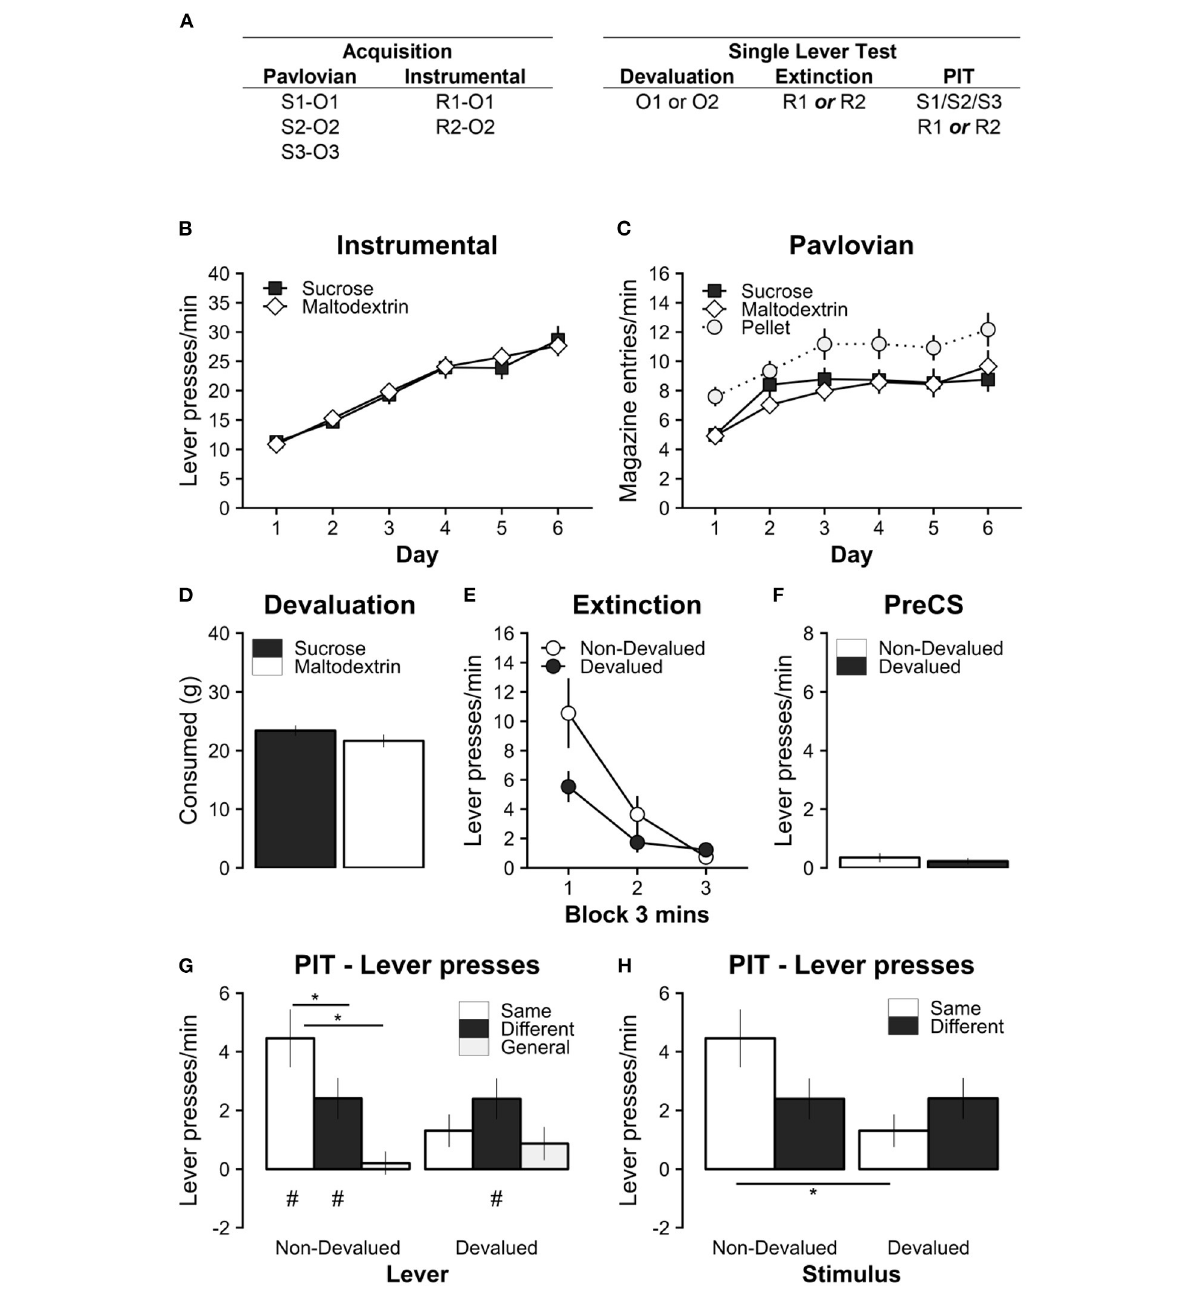
FIGURE2 Experiment 2 tested the effect of outcome devaluation by sensory-specific satiety on specific PIT in a single-lever test. (A) Experimental design; S1/S2/S3: clicker, tone, and noise stimuli (counterbalanced); R1/R2: left and right lever press actions (counterbalanced); O1/O2: sucrose and maltodextrin liquid reinforcer outcomes (counterbalanced); O3: pellet reinforcer outcome. (B) All rats learned to perform the left and right lever responses for the sucrose and maltodextrin liquid reinforcers. (C) All rats learned that the Pavlovian stimuli uniquely predicted the sucrose, maltodextrin, and pellet outcomes. (D) During the 1-hour specific satiety devaluation session, rats consumed a substantial amount of the reinforcer, but consumed slightly more when the reinforcer was sucrose. (E) Outcome devaluation successfully reduced the rate of lever pressing on the lever associated with the devalued outcome during the extinction period with only a single lever present in each test. (F) Baseline responding during the PIT test was similar on the devalued and non-devalued levers. (G) Outcome devaluation abolished specific PIT when separating responses on the non-devalued (Left) and devalued (Right) levers. (H) Outcome devaluation reversed specific PIT when separating responses during the non-devalued (Left) and devalued (Right) stimuli. Note that the same data are presented in (G) and (H) . * Significant simple effects. p < 0.05. # Significant responding above baseline, p < 0.05. Full analysis details in main text. Data are presented as mean ±